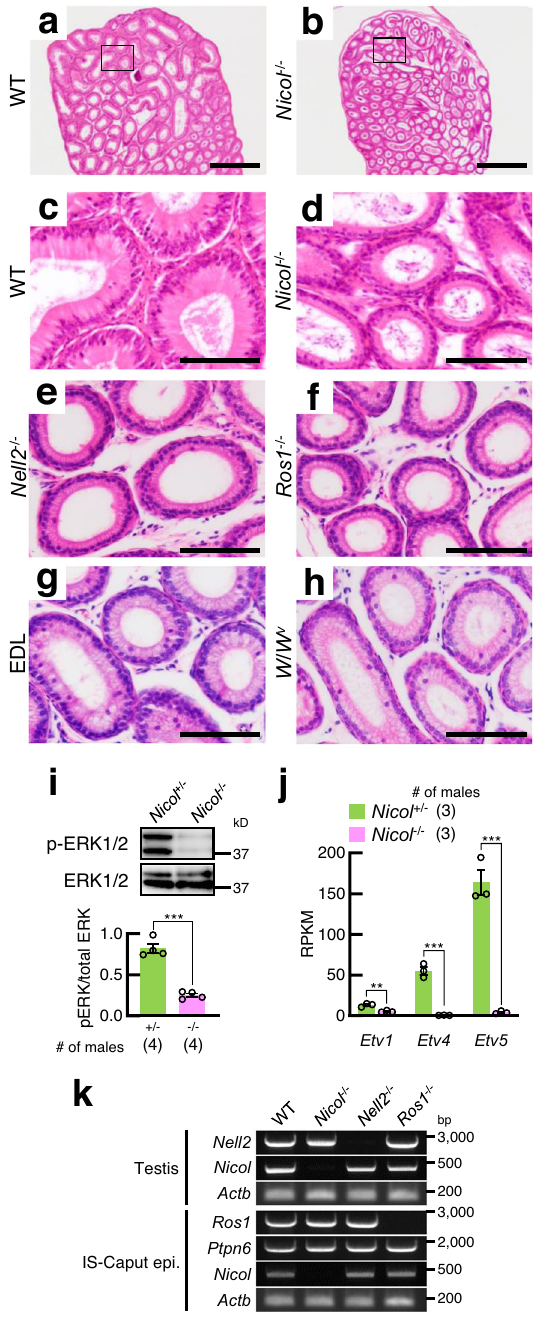
Fig. 4 | Defective epididymal IS epithelium differentiation in Nicol − / − mice is a phenocopy of other lumicrine signalling-de fi cient mice. a – h HE staining of IS sections of epididymis from WT( a , c ), Nicol − / − ( b , d ), Nell2 − / − ( e ), Ros1 − / − ( f ),efferent duct-ligated (EDL) ( g ), and W / W v ( h ) mice. Bars, 500 μ m ( a , b ), 100 μ m ( c – h ). Images are representative ones obtained from three ( a – d , g , h ) or fi ve ( e , f ) inde- pendentbiologicalreplicates. i Immunoblotdetectionofphosphorylatedandtotal ERK1/2 in Nicol +/ − (green columns) and Nicol − / − (pink columns) IS-caput epididymis. Average ERK phosphorylation levels and S.E. shown. j RNA expression of ERK downstreamtranscriptionfactorgenes Etv1 , Etv4 ,and Etv5 in Nicol +/ − and Nicol − / − IS- caput epididymis. Average and S.E. shown. RPKM, reads per kilobase per million. k RT-PCR analyses of Nell2 , Nicol , Ros1 , and Ptpn6 expression in Nicol − / − testis and caput epididymis. Actb shown as internal control. Images are representative ones obtained from three independent biological replicates. For bar plots, values are shown as mean±S.E.M. P value=0.0001 ( i ) and 0.006, 0.0004, and 0.0005 for Etv1 , Etv4 , and Etv5 , respectively ( j ), were determined by a two-tailed